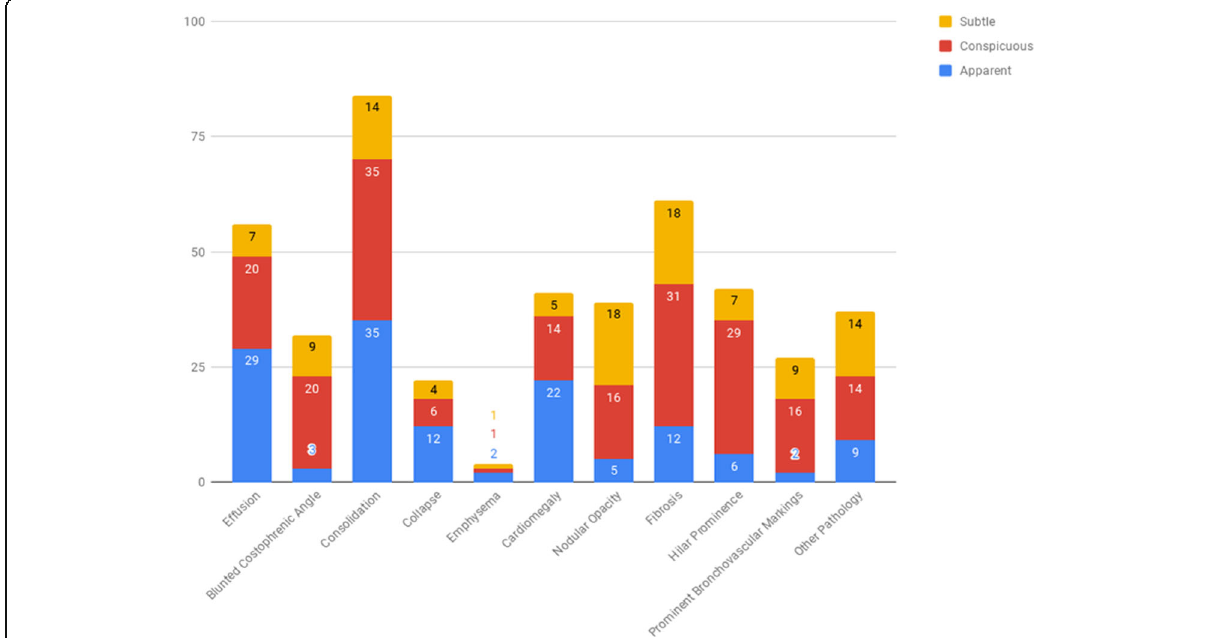
Fig. 2 Distribution of conspicuousness of pathology in the training data